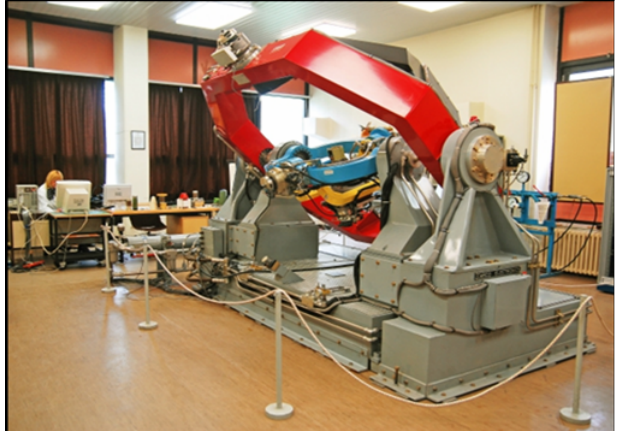
Figure 1 – HIL laboratory with five axis missile and target flight simulator Рис . 1 – ПАМ Лабораторный пятиосевой имитатор движения ракеты и